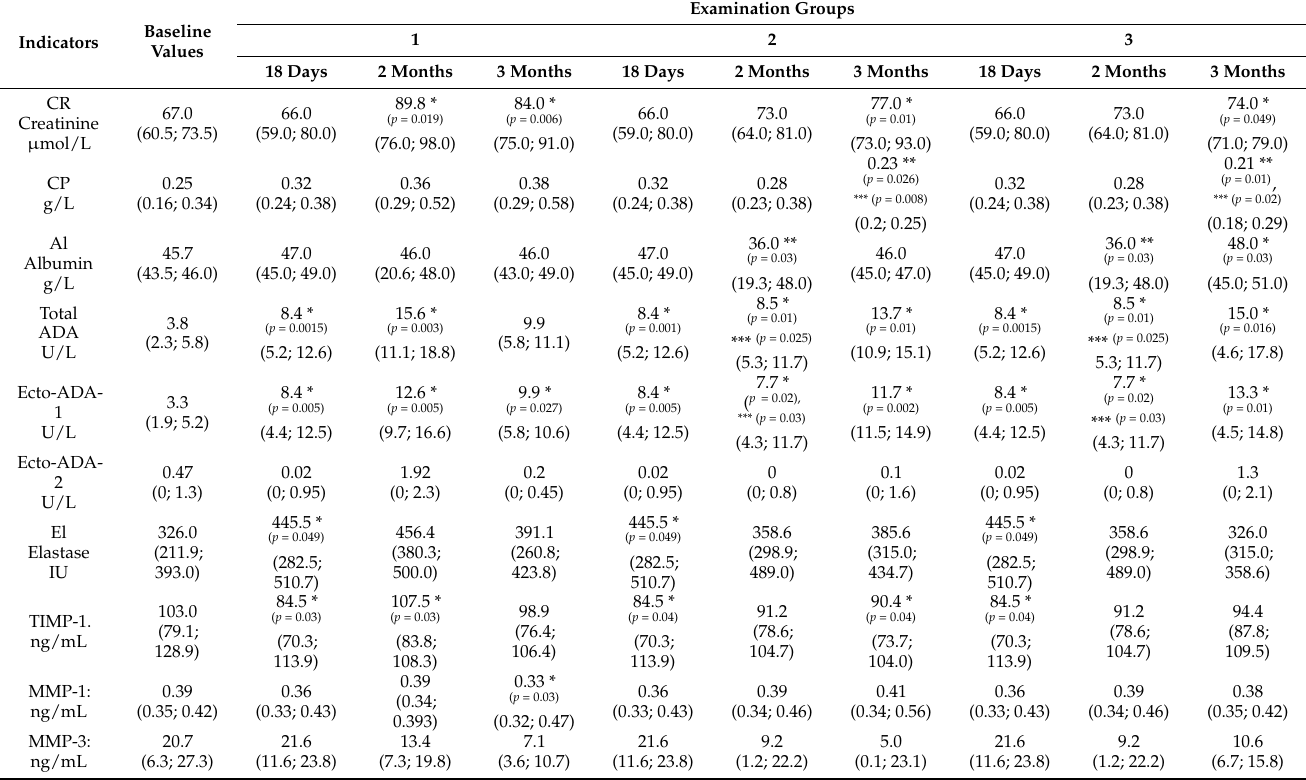
Table 1. Biochemical indicators in the studied